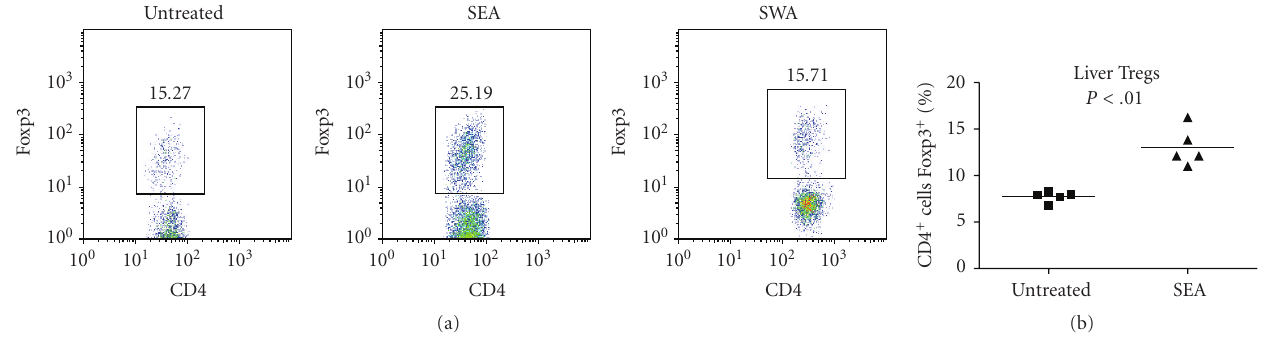
Figure 6: Egg, but not worm, antigens drive Foxp3 + Treg responses. SEA treatment increases the representation of Foxp3 + Tregs in the pancreas (a) and liver (b) of NOD mice. Female NOD mice were treated at eight weeks of age with 50 μ g SEA or SWA on day 0 and day 7. Pancreatic infiltrating cells were isolated and stained for intracellular Foxp3 expression on day 10. Statistical analysis by Mann Whitney U test, two-tailed.